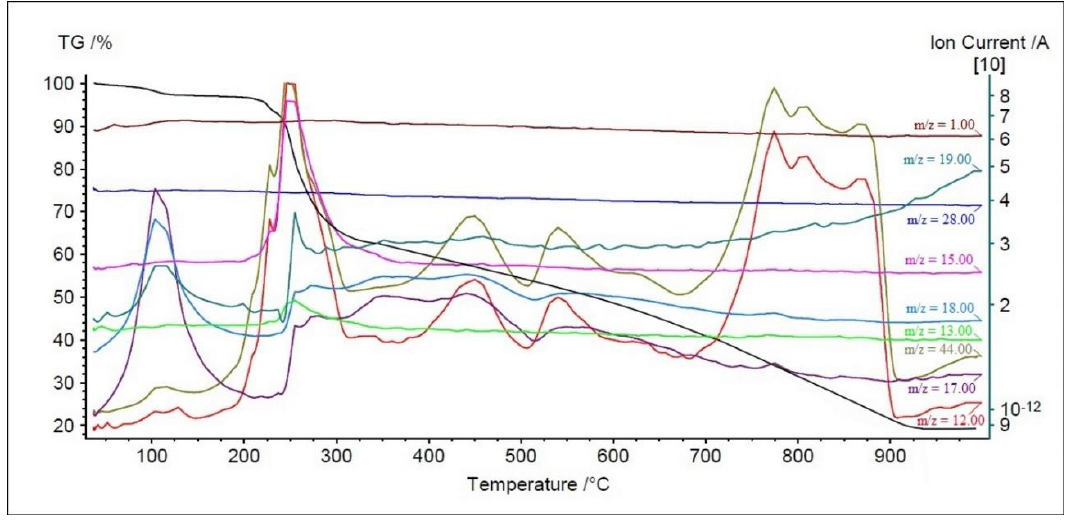
Figure 1. TG curve for Sm(III) complex and ion current detected by MS spectra for several mass fragments.